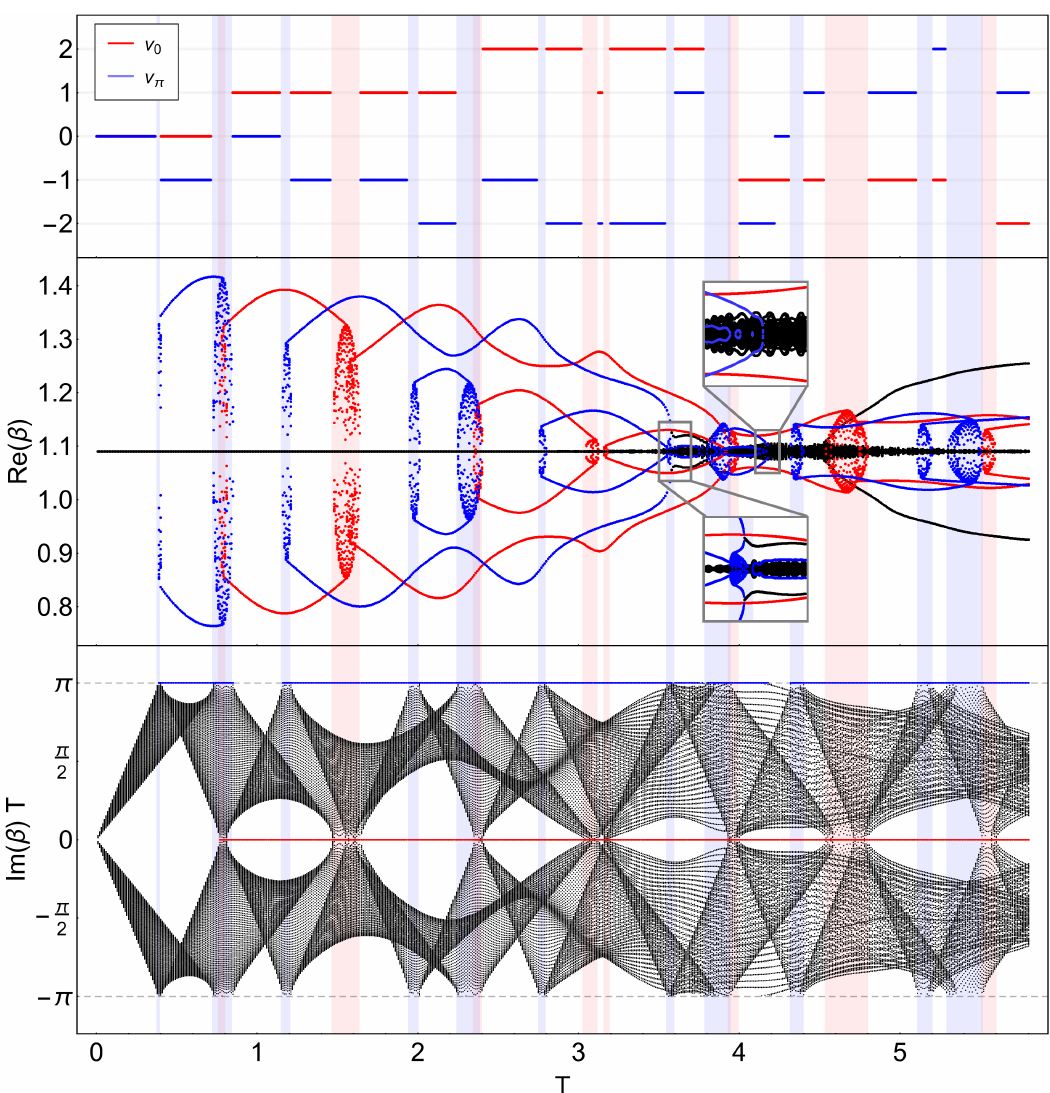
Figure 5: Winding numbers (top panel) and quasi-rapidities for OBC (middle and bottom panels) as a function of the driving period T . In all three panels, shaded regions correspond to broken AUS, with the bulk band gap closing either at β = a 0 + i π/ T (blue background). The winding numbers ν (red background) or β = a 0 0 and ν π are shown only outside these regions. The real and imaginary parts of the quasi-rapidity spectrum under OBC are shown in the bottom two panels. Red dots correspond to quasi-rapidities with Im ( β ) = 0, and blue dots to Im ( β ) = π/ T . The edge modes corresponding to each of these gaps can be seen clearly in the real part of the spectrum as lines connecting different AUS-breaking ‘bubbles’. The number of | and | ν | respectively. The insets in pairs of red and blue edge modes is given by | ν π 0 the middle panel show magnifications of regions where edge modes hybridize. The = 12, µ = 0, and parameters are: N = 100, J = 1, γ = 0.8, g = 1.0, ∆ = 0.3, µ 1 2 = t t 1 2